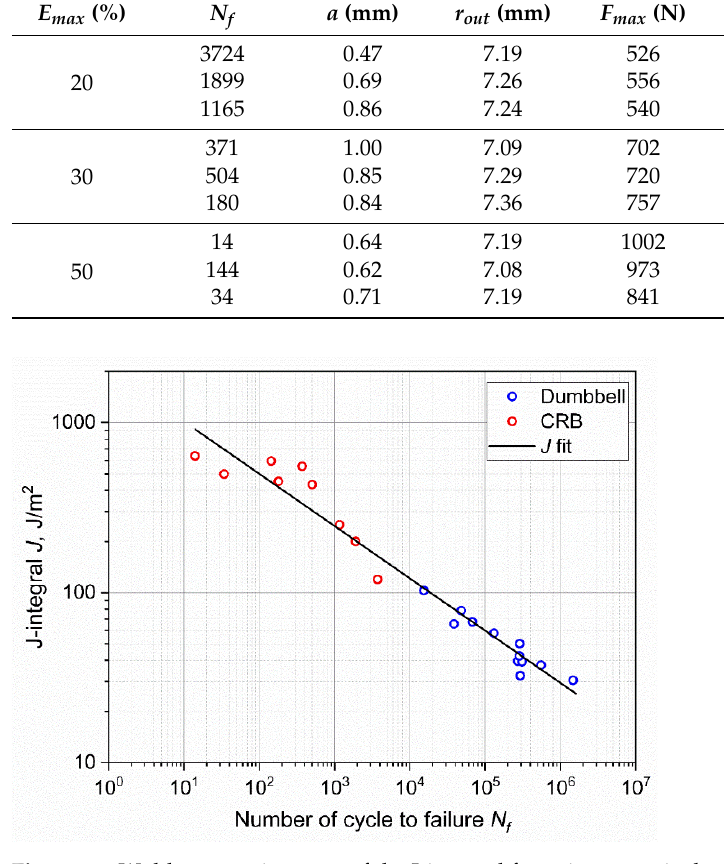
Figure 18. Wöhler curve in terms of the J-integral for axisymmetric dumbbell (blue) and CRB (red) specimens. A unique fitting line was found correlating the two geometries.